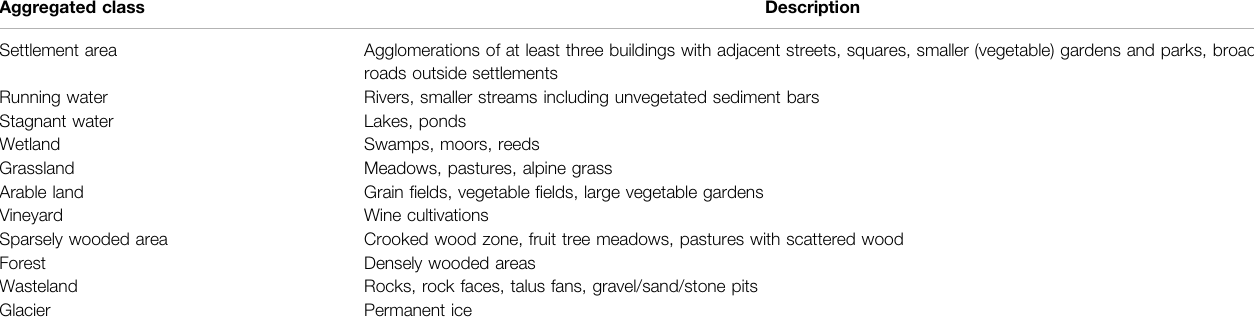
TABLE 1 | Aggregated classes de fi ned for the analysis of the historical and current land cover/use. Aggregated